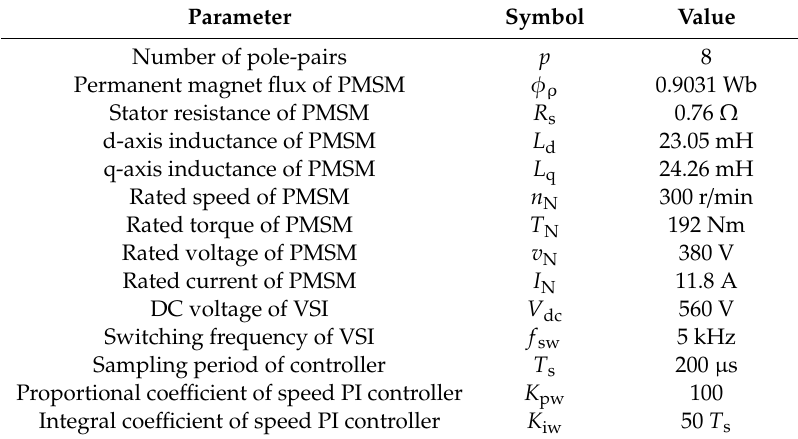
Table 1. Parameters of the control